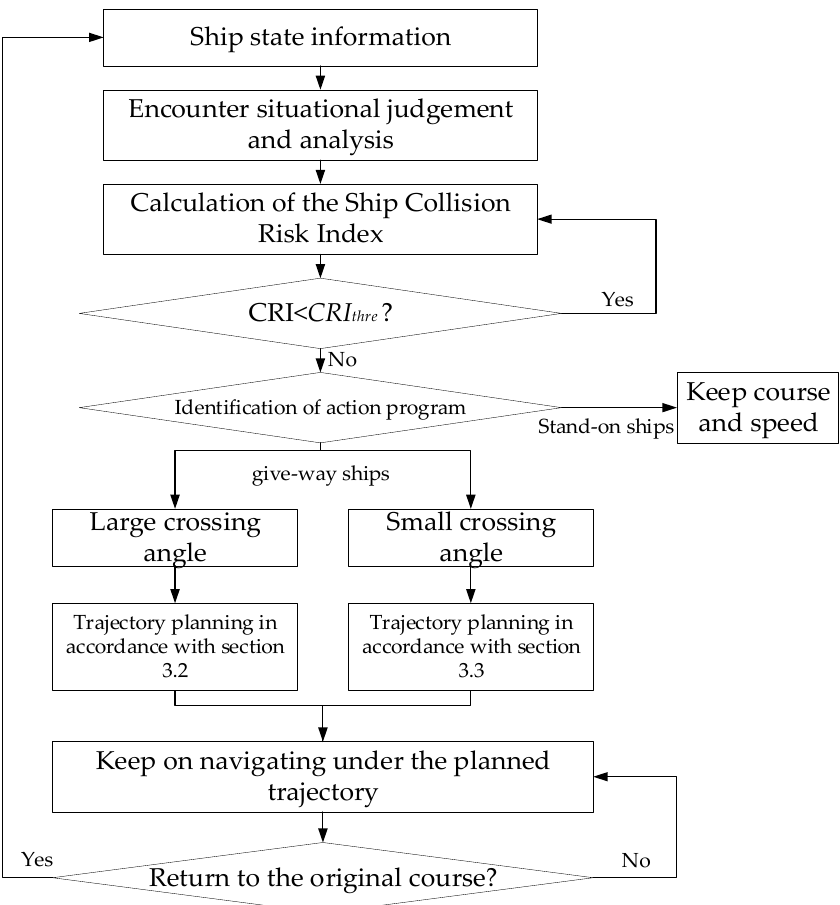
Figure 4. Trajectory planning procedure for the own ship (OS). Where CRI represents collision risk index, CRI thre refers to collision risk index thresholds.